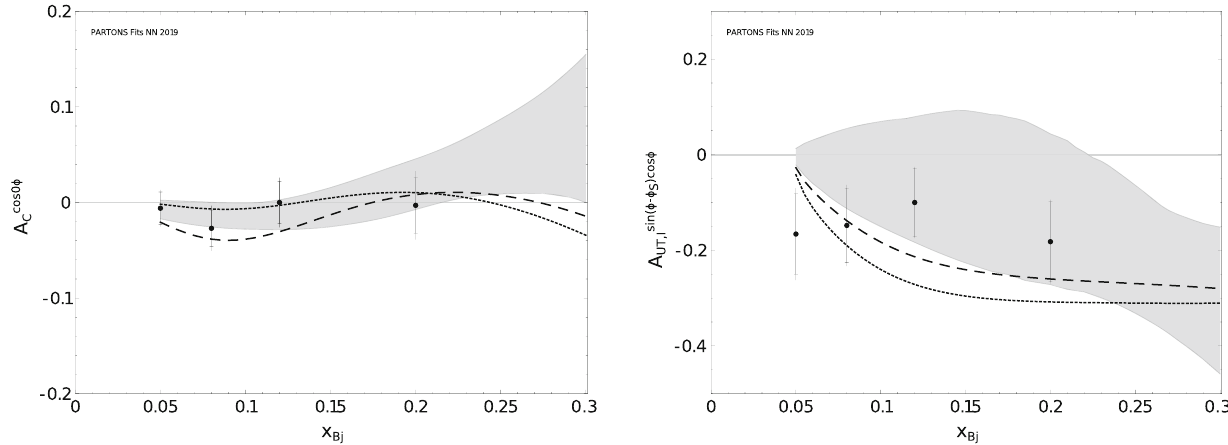
Fig. 14 Comparison between the results of this analysis, the selected GPD models and the experimental data published by HERMES in Ref. [42] φ (φ − φ S ) cos φ for A cos0 (left) and A sin (right) at t = − 0 . 12 GeV 2 and Q 2 = 2 . 5 GeV 2 . For further description see the caption of Fig. 12 C UT , I